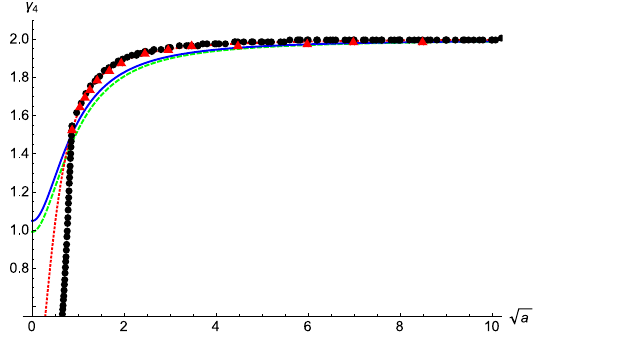
4(2017)137 (1 = 2 + i=g ) 3